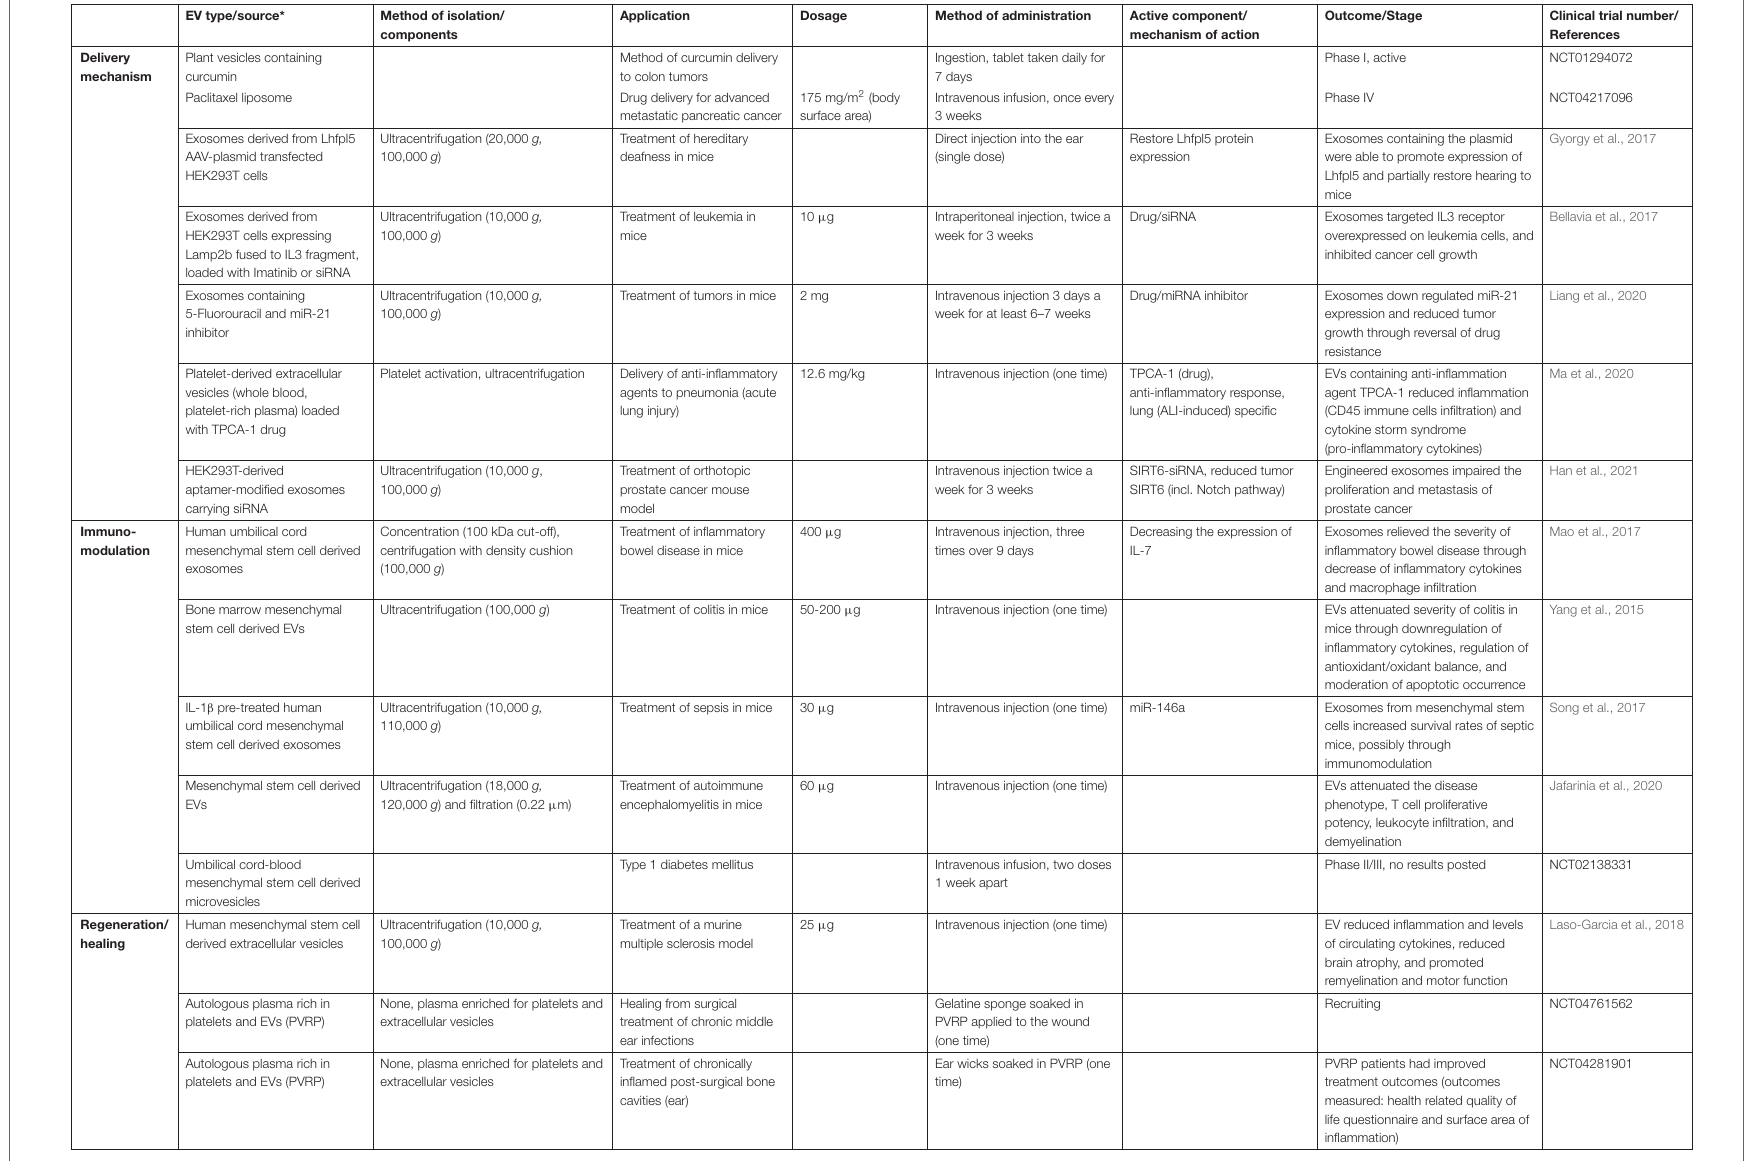
TABLE 1 | Clinical and preclinical applications of extracellular